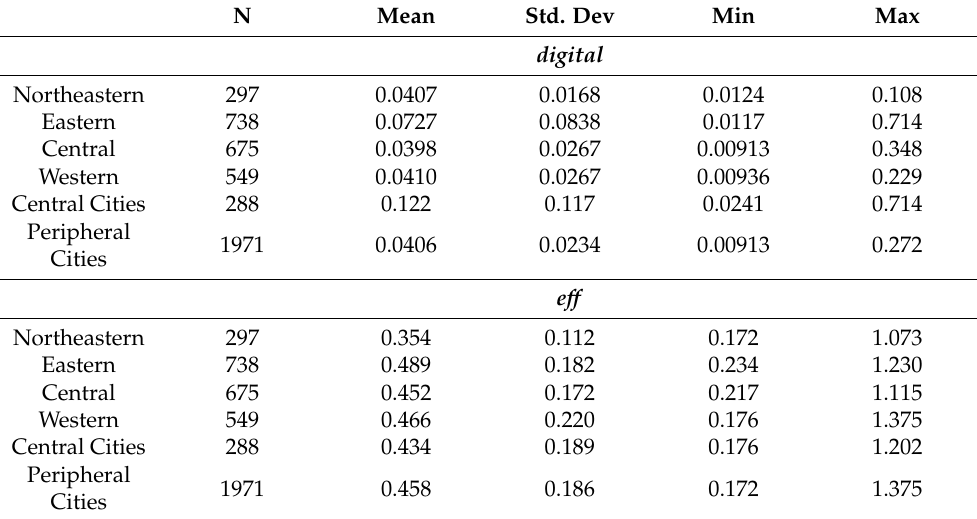
Table 6. Regional digital economic development level and carbon emission